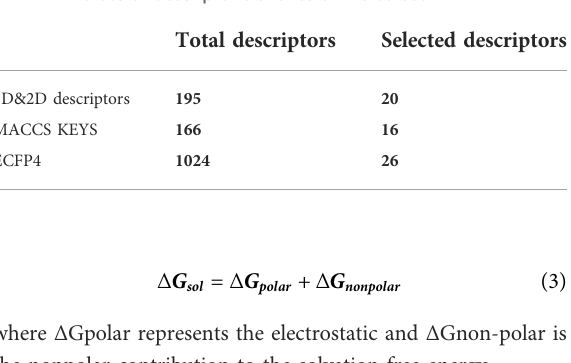
TABLE 2 Molecular descriptor statistics of the